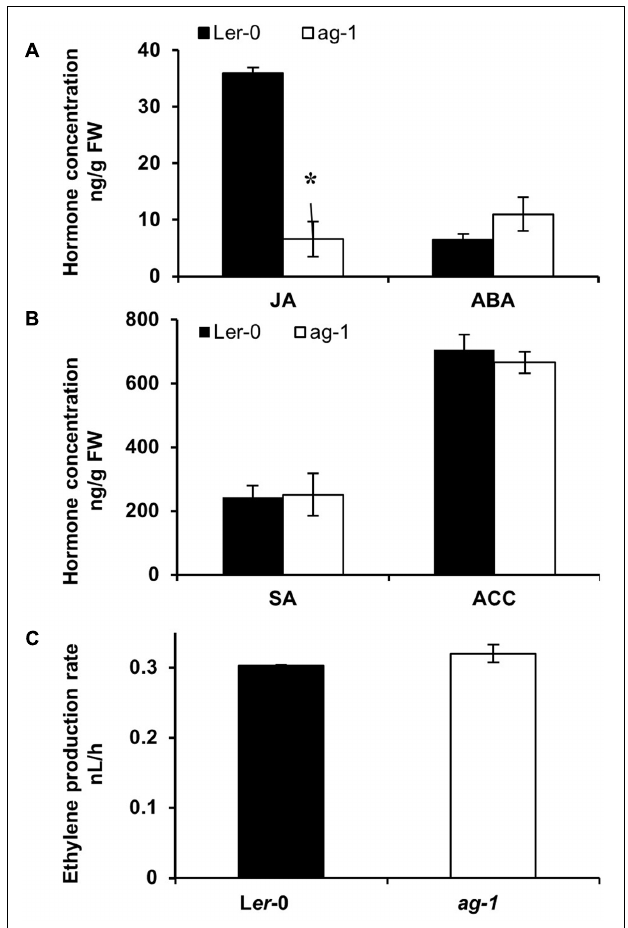
FIGURE 3 | Endogenous hormone concentrations in L er -0 and ag-1 inflorescences. (A,B) Endogenous hormone concentrations in L er -0 and ag-1 inflorescences. (C) Ethylene evolution in detached inflorescences. Plants were grown under long-day conditions for 8 weeks and flowers were detached and sepals were snap frozen for hormone analyses. Jasmonic acid (JA), 1-Aminocyclopropane-1-carboxylic acid (ACC), Abscisic acid (ABA), and Salicylic acid (SA) concentrations were measured as described in the Section “Materials and Methods.” Ethylene evolution was measured from detached inflorescences as described in the Section “Materials and Methods.” The error bars represent the standard error of two biological replicates. ∗ Indicates statistically significant ( p < 0.006) between the L er -0 and ag-1 inflorescences using Student’s t -test. FW, Fresh Weight. Student’s t -test at p < 0.05 showed that ethylene evolution between L er -0 and ag-1 inflorescences was not